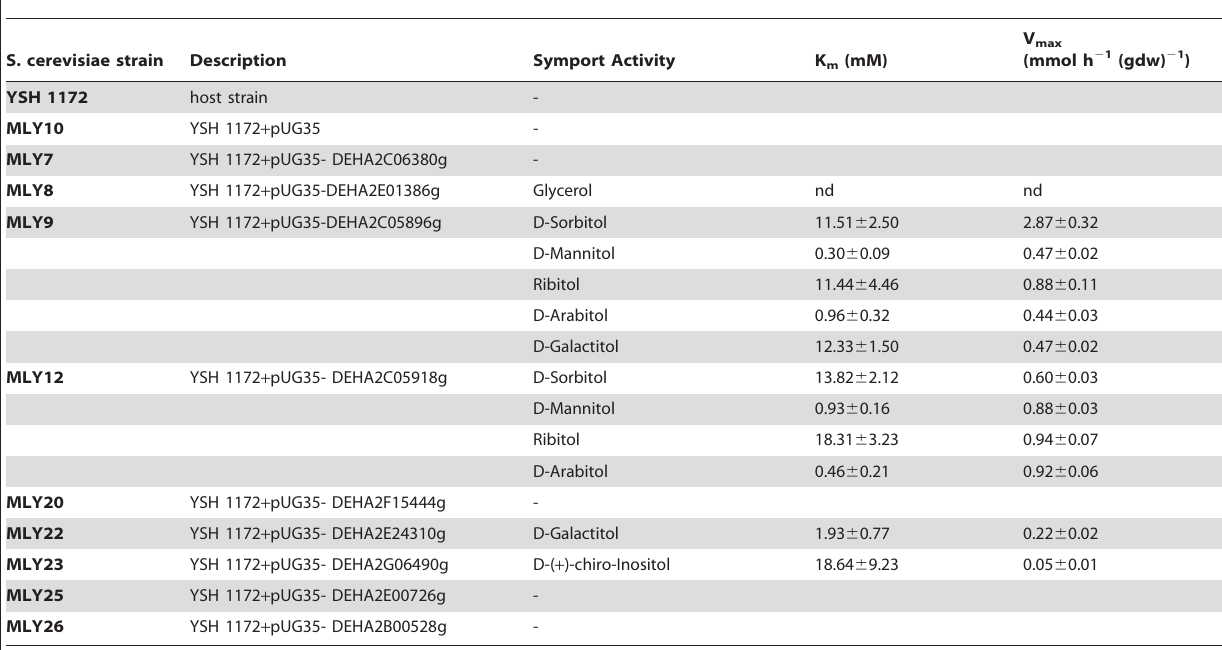
Table 4. Symport activity detected in the S. cerevisiae strains constructed in this work.